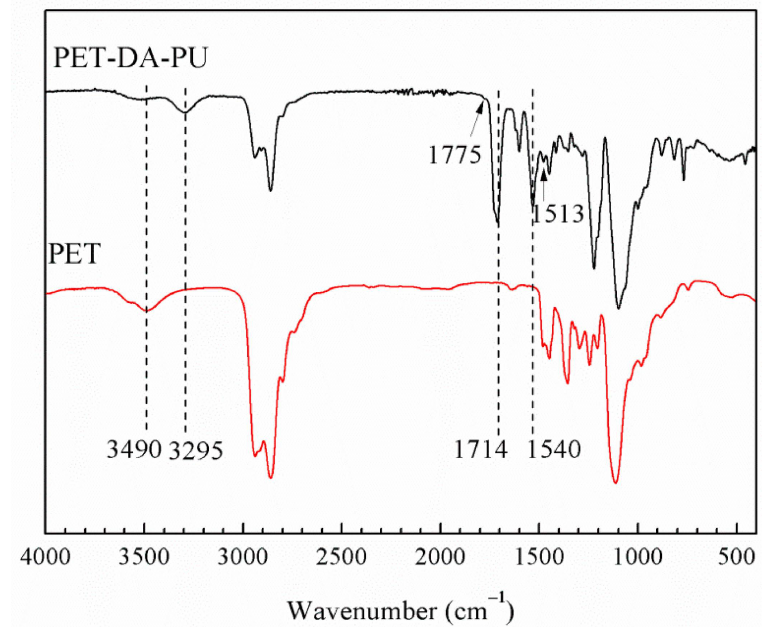
Figure 1. ATR-FTIR spectra of PET-DA-PU and PET.